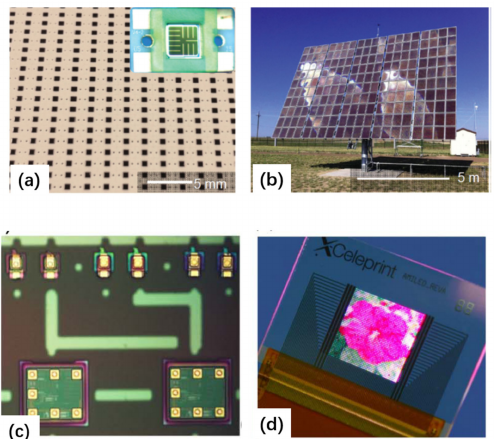
Figure 24. ( a ) Photograph of transfer-printed multijunction GaAs solar cells on a low-cost ceramic sub-mount substrate. The inset shows a magnified view. ( b ) A pilot-scale commercial concentrator module with a certified efficiency of 35.5%. Adapted with permission from [106]. Copyright John Wiley and Sons, 2015. ( c ) A transfer-printed unit consisting of RGB micro-LED subpixels and corresponding driver IC. Adapted from [99] ( d ) Active micro-LED display made from the printed units shown in ( c ). The interconnection is based on electroplated copper. Adapted from